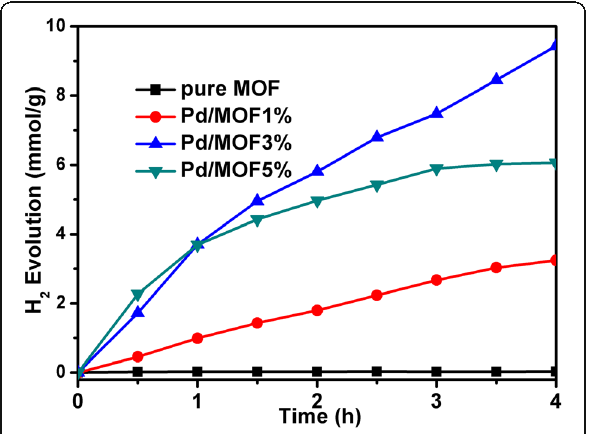
Fig. 8 The photocatalytic activities of pure MOF, Pd/MOF 1%, Pd/ MOF 3%, and Pd/MOF 5% for hydrogen